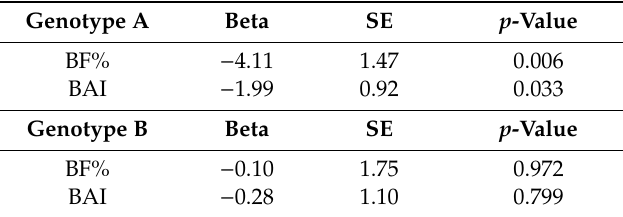
Table 3. Linear regression table of the e ff ect of low vs. high vitamin A intake on adiposity depending on the Genotype A / B 1